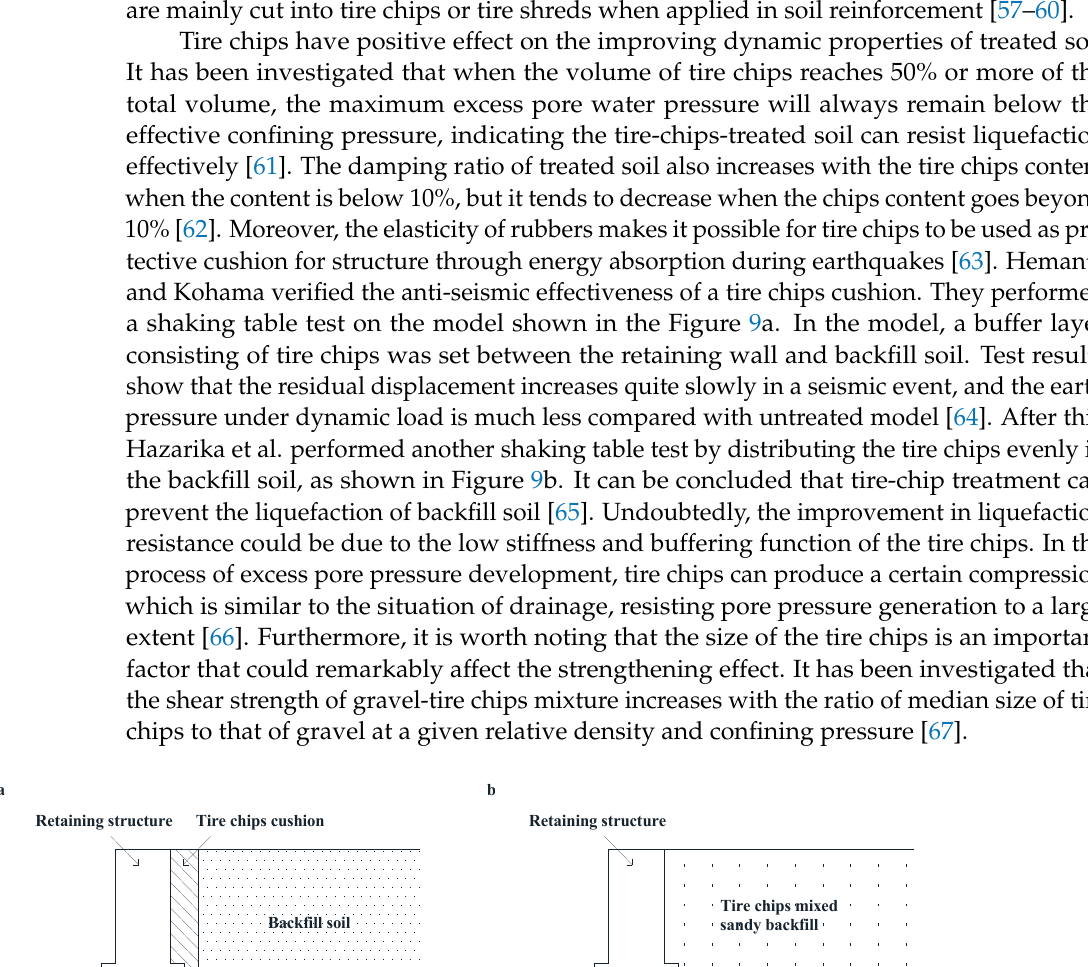
Figure 8. The relationship between cyclic stress ratio and number of cycles to liquefaction for sand samples treated by MICP [55].